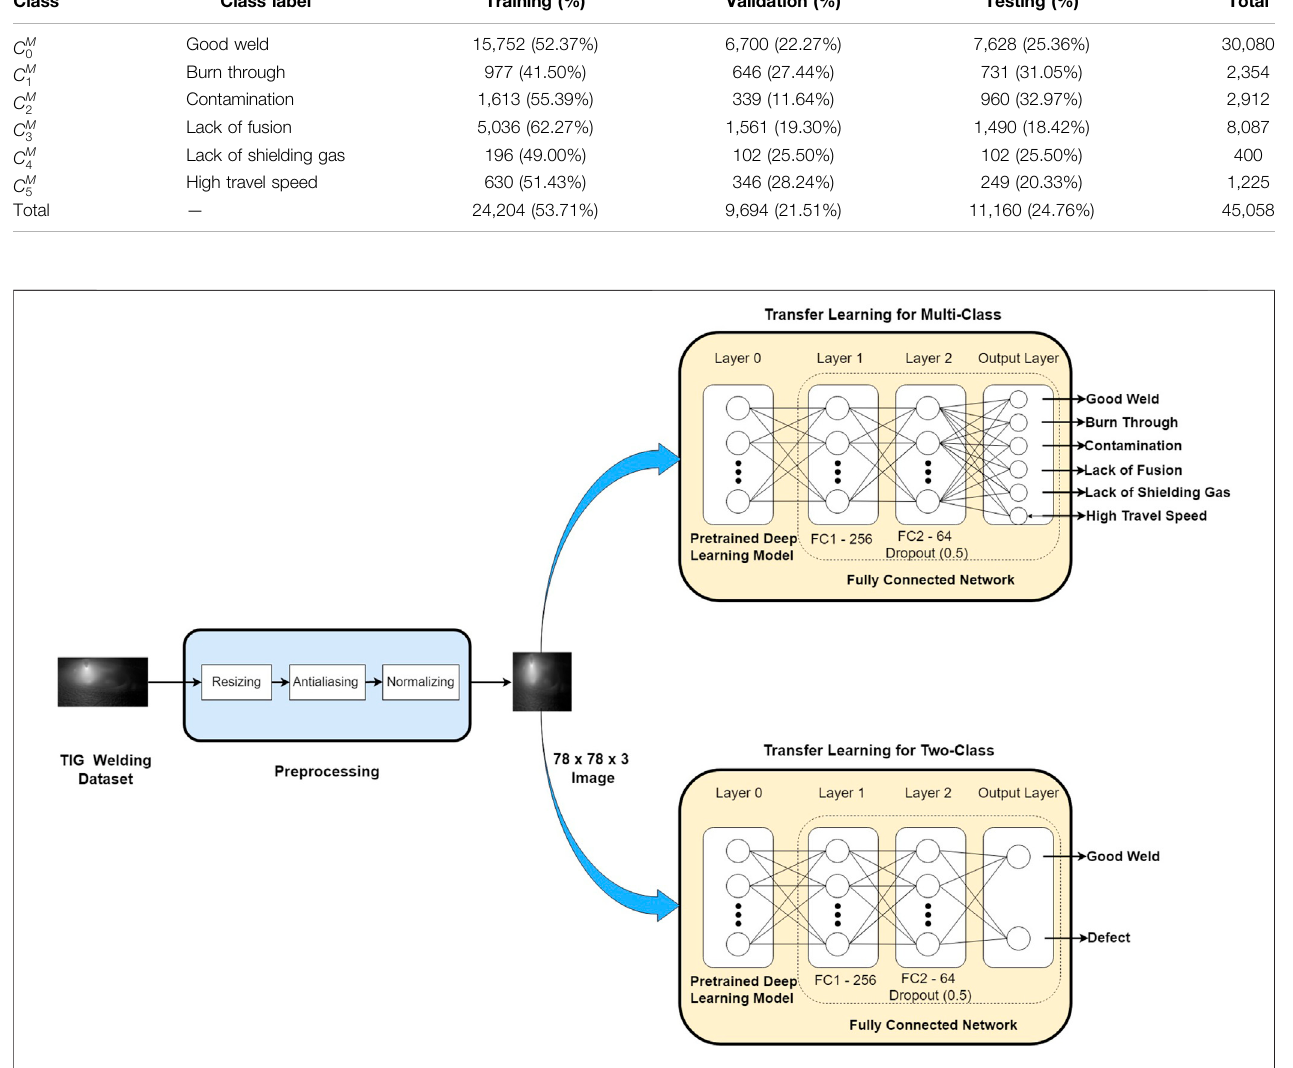
Frontiers in Mechanical Engineering |